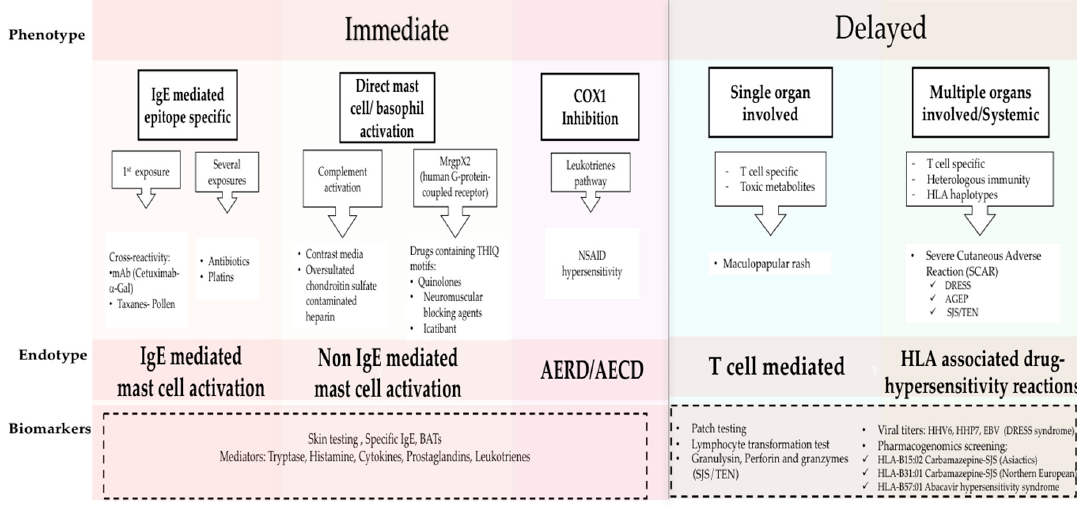
Figure 1. Phenotypes and Endotypes in drug allergy. The new classification of DHRs is based on phenotypes, endotypes and biomarkers. Phenotypes include immediate and delayed reactions; the clinical presentations of each phenotype are mediated by different immunological mechanisms which are defined by endotypes. Biomarkers are used to identify the Endotypes (dash line box). Adapted from Muraro, Antonella, et al. “Precision Medicine in Allergic Disease–Food Allergy, Drug Allergy, and Anaphylaxis-PRACTALL document of the European Academy of Allergy and Clinical Immunology and the American Academy of Allergy, Asthma & Immunology.” Allergy (2017) [1]. BAT, basophil activation test; mAb, monoclonal antibody; α -Gal, galactose-alpha-1,3-galactose; NSAID, nonsteroidal anti-inflammatory; AERD, Aspirin Exacerbated Respiratory Disease; AECD, Aspirin Exacerbated Cutaneous Disease; HHV 6, human herpesvirus 6; HHV 7, human herpesvirus 7; EBV, Epstein Barr Virus; DRESS, Drug reaction with Eosinophilia and Systemic Symptoms; AGEP, Acute Generalized Exanthematous Pustulesis; SJS-TEN, Stevens-Johnson Syndrome and Toxic Epidermal Necrolysis.